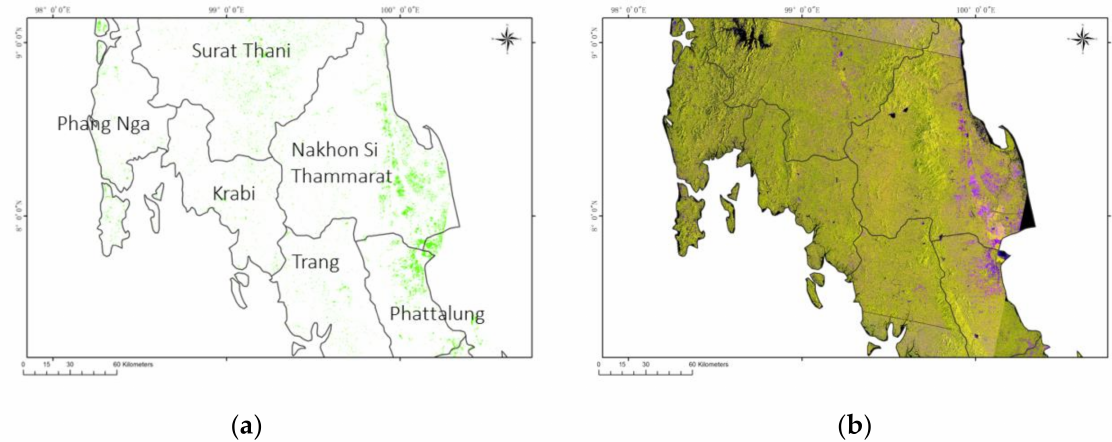
Figure 20. Paddy rice mapping result of Nakhon Si Thammarat (southern Thailand): ( a ) paddy rice mapping result and ( b ) false-color image of the temporal features.